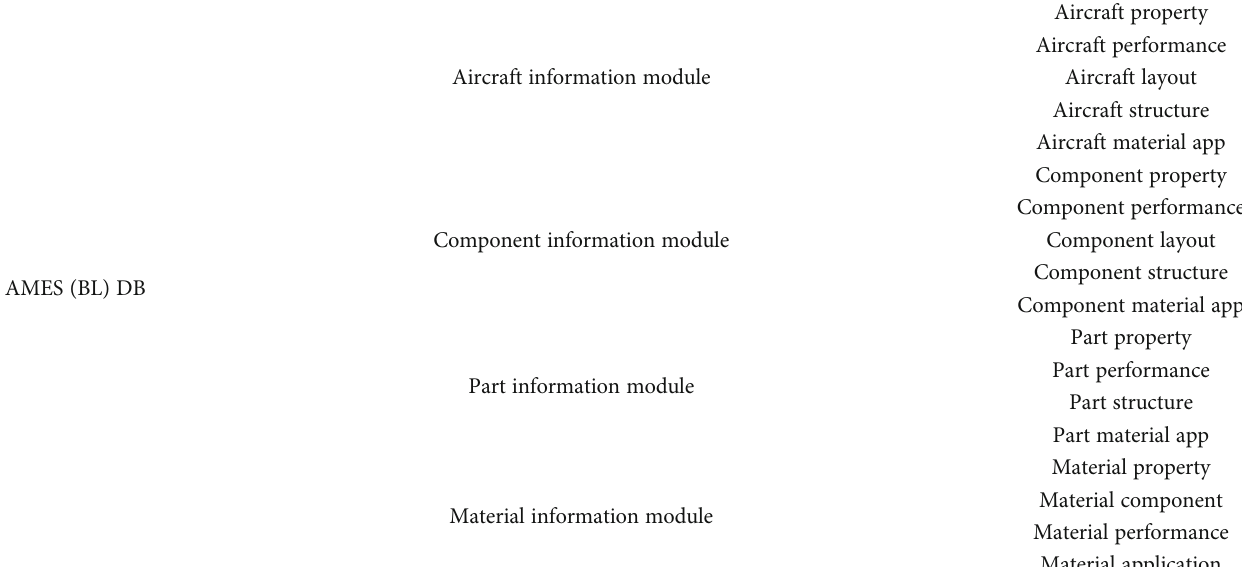
Table 1: Frame of data base.